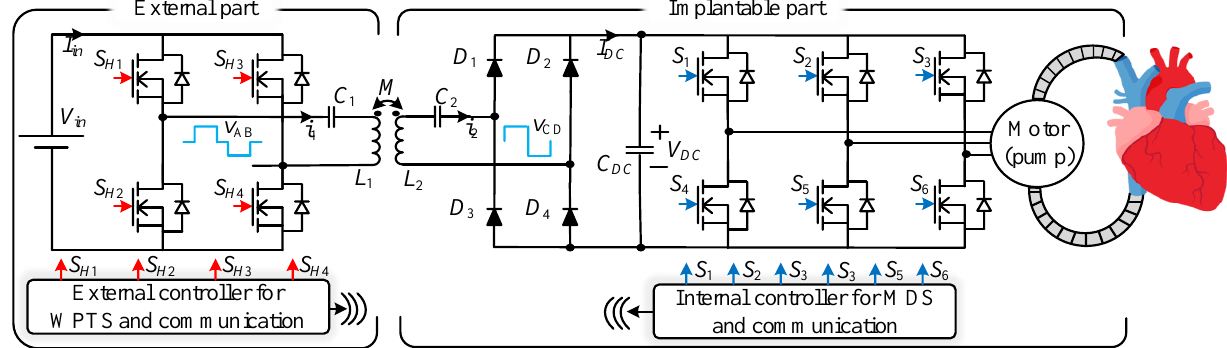
Internal controller for MDS and communication Figure 1. General Schematic of MDS supplied by WPTS for a VADS. Figure 1. General Schematic of MDS supplied by WPTS for a